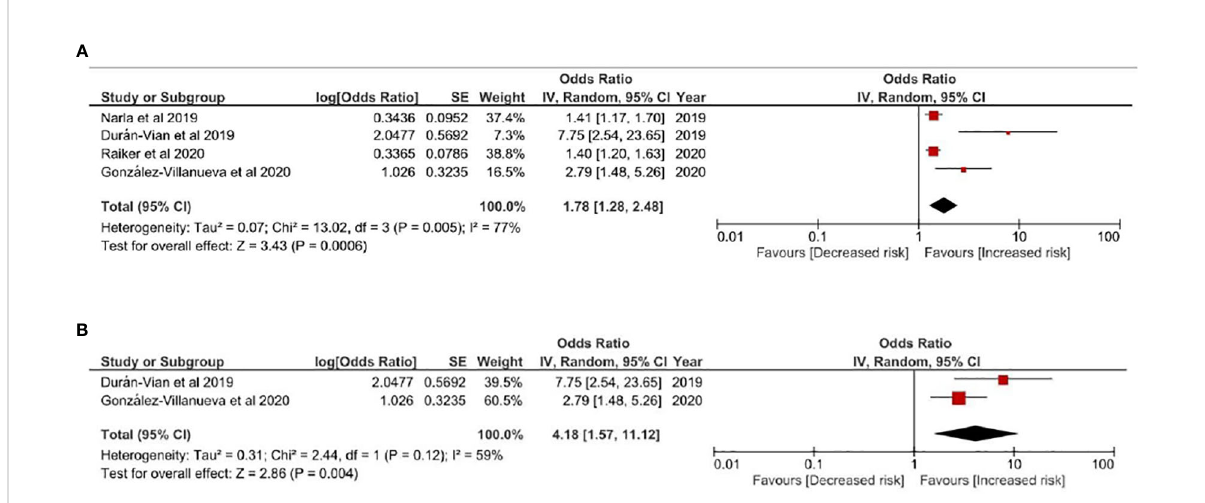
FIGURE 3 (A) Odds ratio of all pooled evidences of NAFLD in people with Hidradenitis Suppurativa (B) Sensitivity Analysis: Odds ratio of NAFLD in people with Hidradenitis Suppurativa based on results controlling obesity related factors Legends: Given obesity was highly involved in both HS and NAFLD, obesity-related factors were critical of considering while evaluating HS-NAFLD association. In this model, studies not adjusting obesity related factors such as BMI or metabolic syndrome comorbidities were excluded from the qualitative